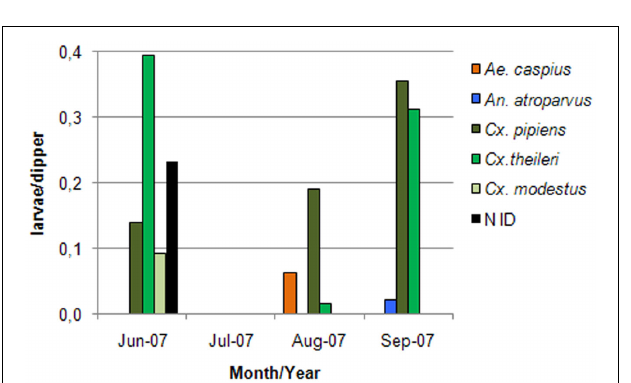
FIGURE 3 | Mean adult mosquito species composition of the seven surveyed lagoons in the wetlands of theAlgarve collected by CDC traps, from June to September, 2007.